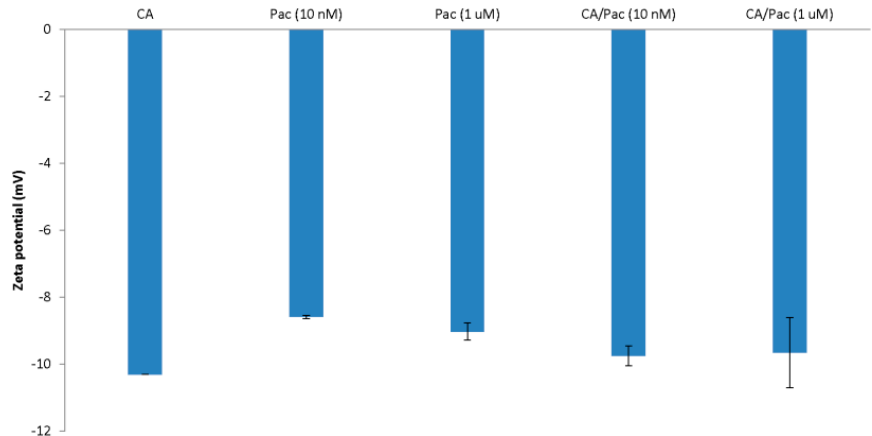
Figure 3. Zeta potential measurement for carbonate apatite particle complexes formulated by incorporation of 3 mM of CaCl 2 together with 10 nM and 1 uM pac. The samples were then incubated at 37 °C for 30 min and also exposed to 10% FBS and maintained on ice prior to size measurement. Size of CA formed with 3 mM of Ca is reported as less than 50 nM. By incorporation of 10 nM pac, NPs reach the maximum size of around 170 nm.